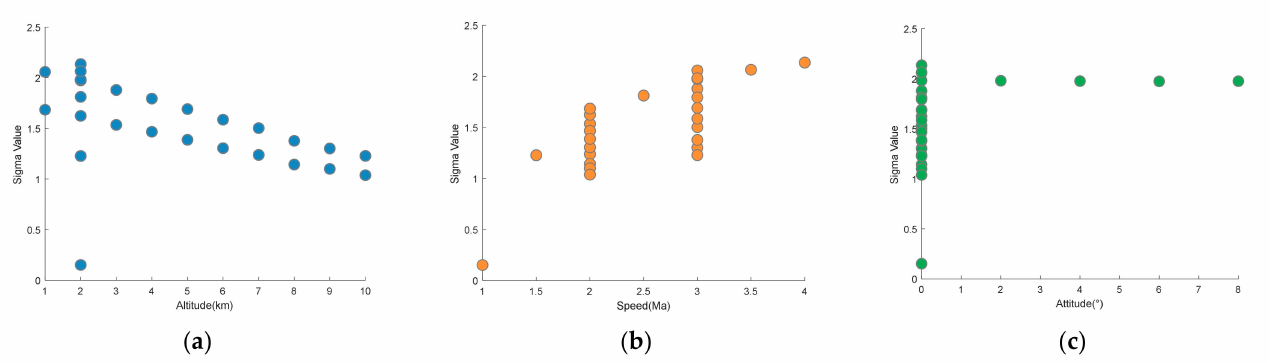
Figure 5. Scatter diagram of the value of σ versus flight altitude, speed, and attitude: ( a ) σ values varying with altitude; ( b ) σ values varying with speed; ( c ) σ values varying with